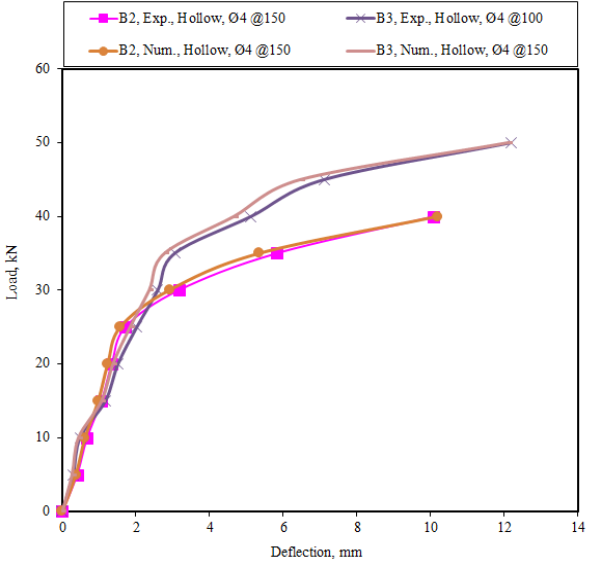
Figure 18. Experimental and numerical load versus mid-span deflection curves of the RC beams B2 and B3 (hollow circle).